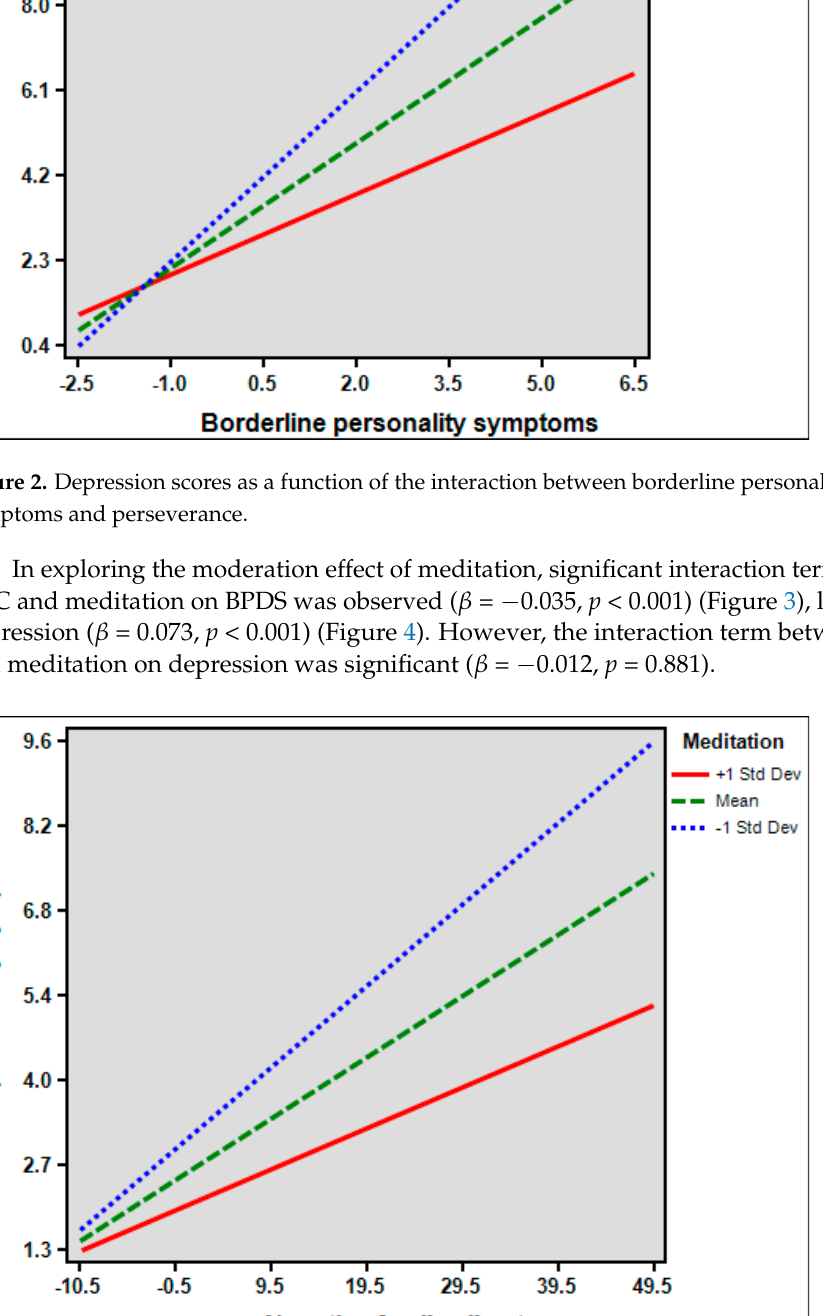
Figure 1. Depression scores as a function of the interaction between Negative Family Climate and perseverance.